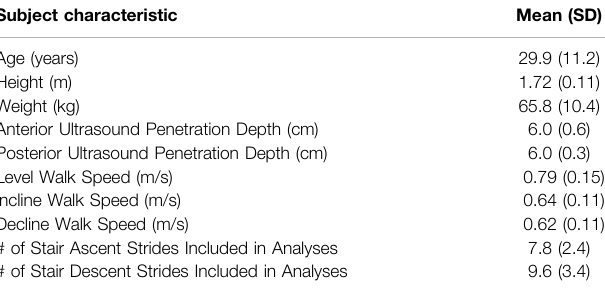
TABLE 1 | Mean and standard deviation (SD) subject characteristics ( N =